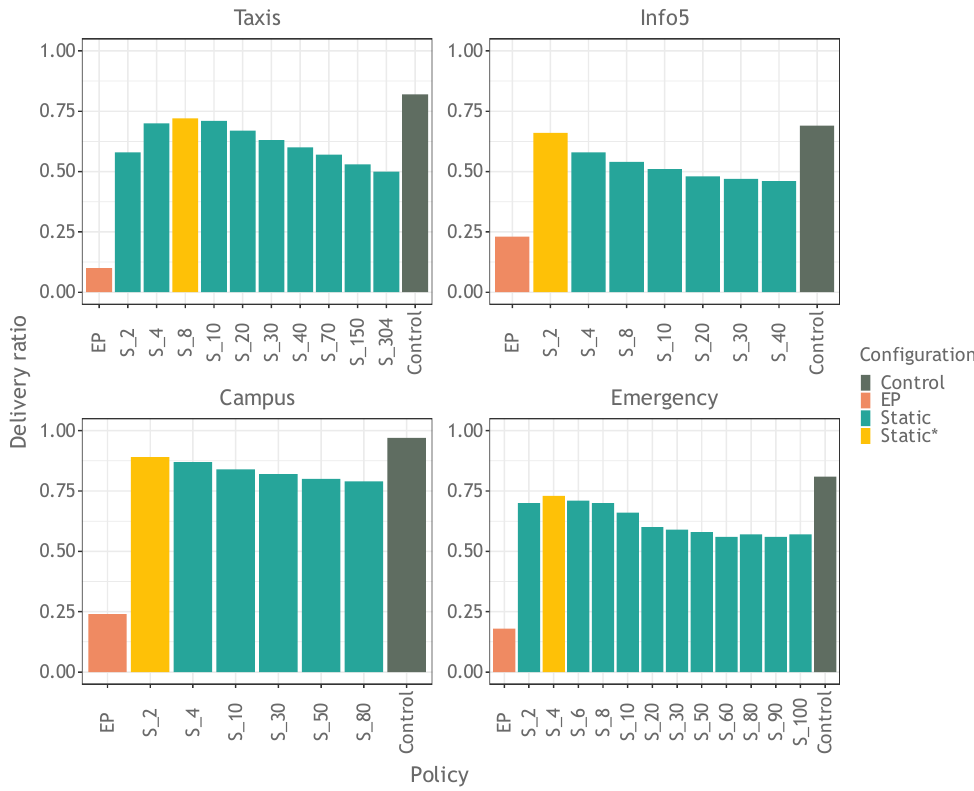
Figure 10. Delivery ratio percentage for the different forwarding policies per